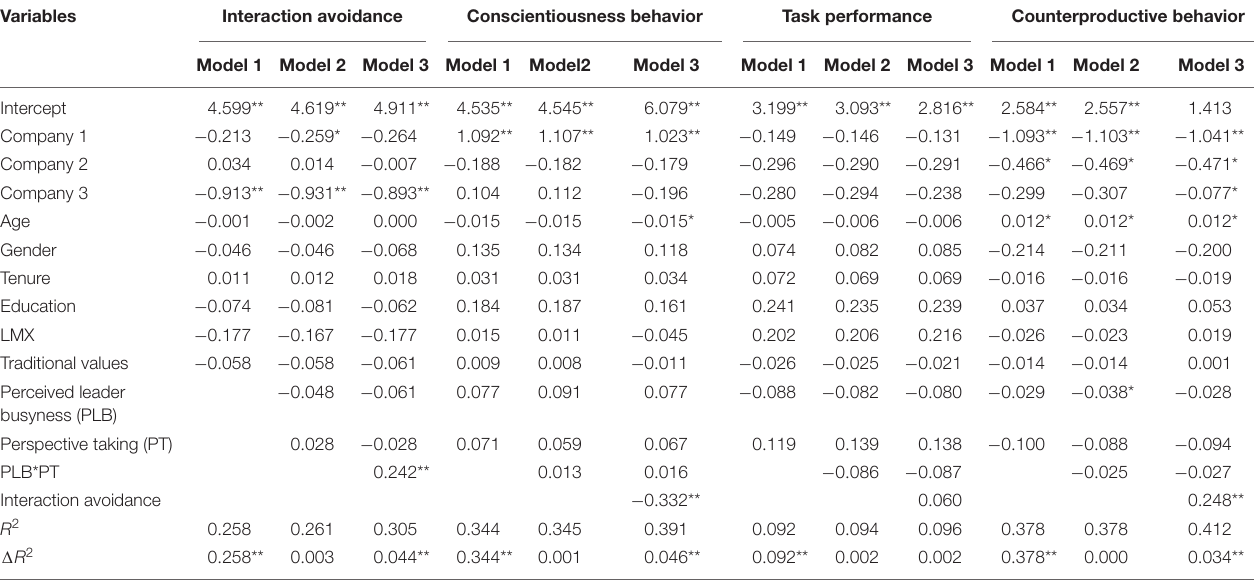
TABLE 7 | Unstandardized regression coefficients.